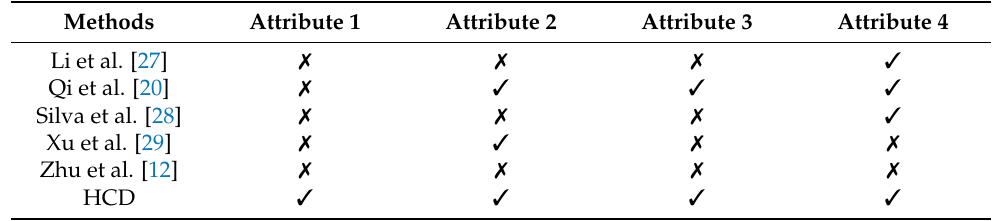
Table 3. Comparison results of the HCD method with other multi-layer and hidden community detection